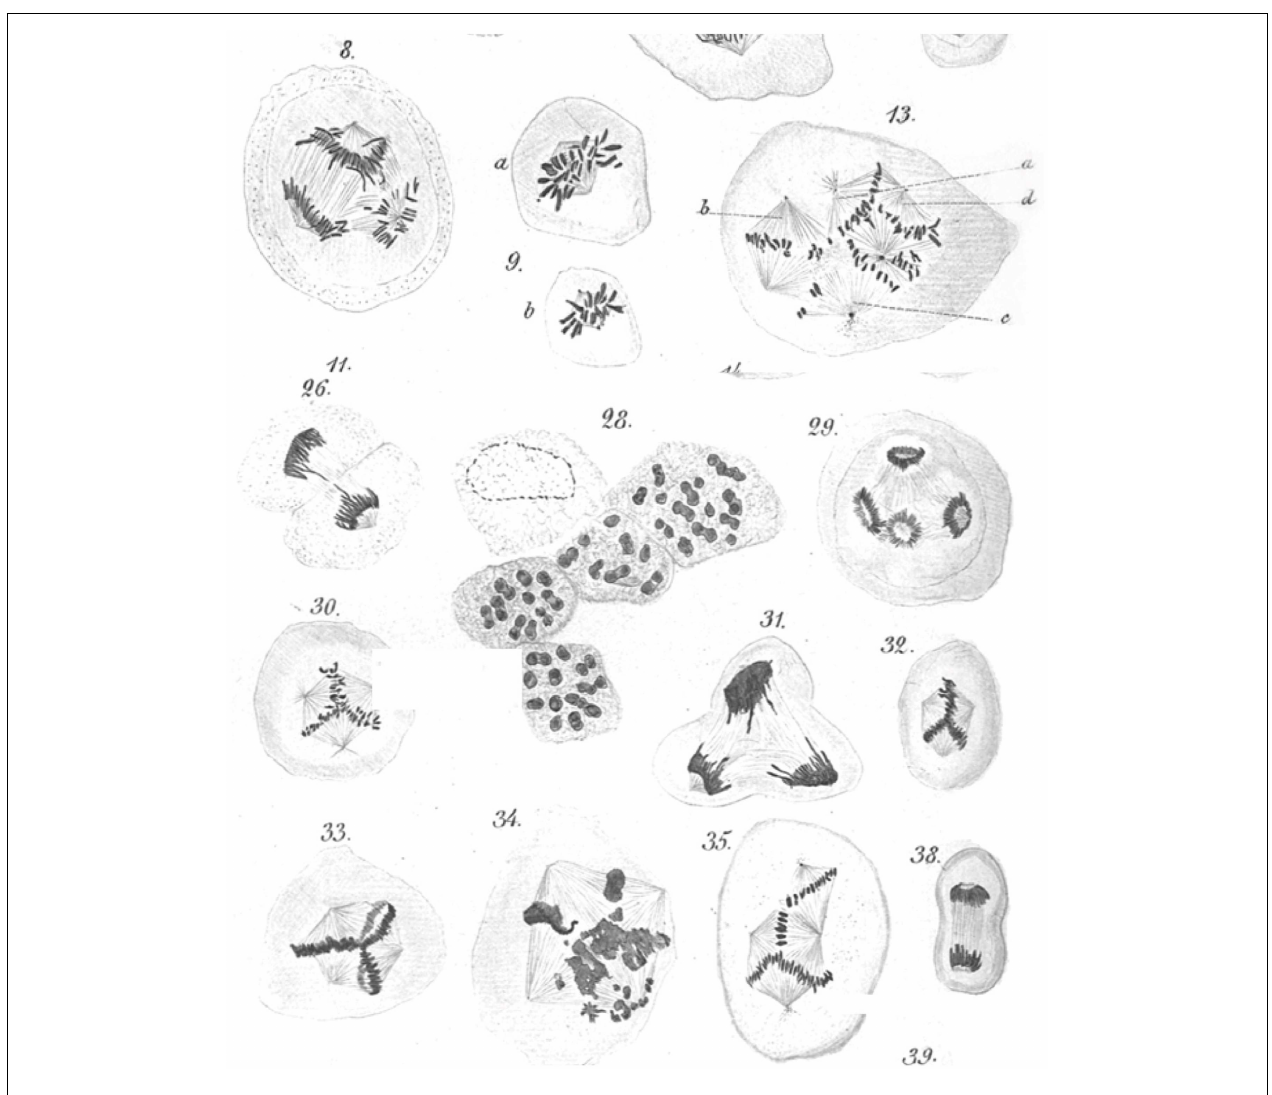
catastrophes are represented as well (28, 34) (reproduced with permission fromVirchows Archive). Hansemann took care of placing cancer tissue samples in warm fixative immediately after surgical resection to avoid anoxia-induced changes and in the process beautifully preserved spindle